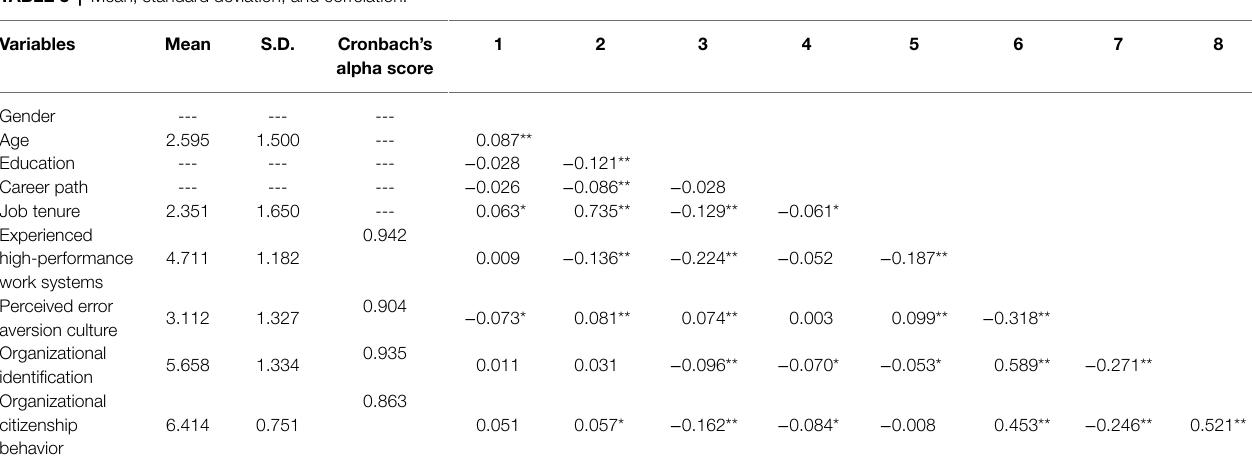
TABLE 3 | Mean, standard deviation, and